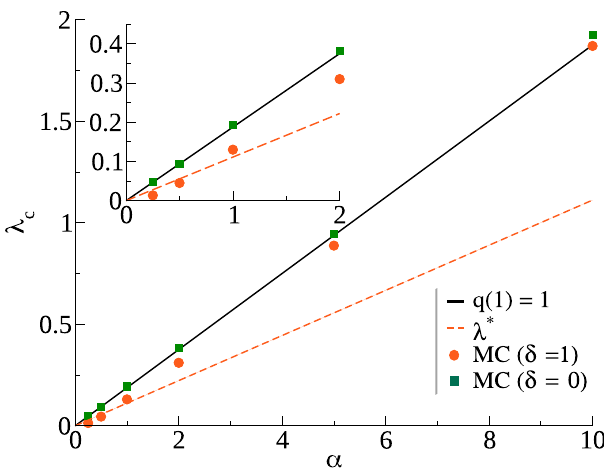
Fig. 4 Comparison between analytical and Monte Carlo critical point estimations ( λ c ). Results for random regular networks with 〈 k 〉 k = 10 and δ = 1 and N = 10 6 . The continuous line expresses the value of λ a solution of q (1) = 1, from Eq. (5). In contrast, the dashed line represents the naive approximation that accounts only for the probability that the next event is spreading or sti fl ing. In the inset we present the comparison for the low α